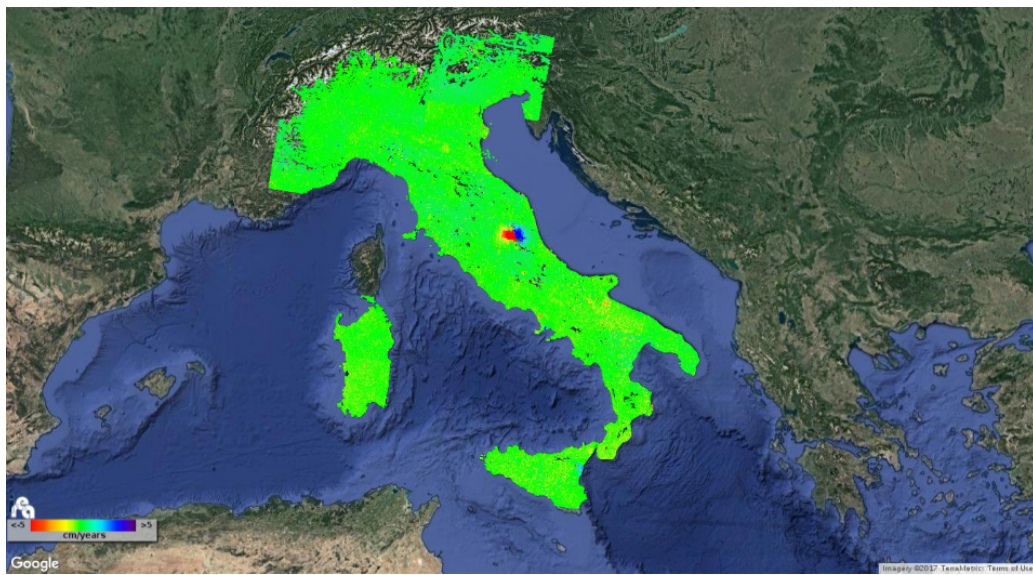
Figure 12. Sentinel-1 DInSAR mean deformation velocity map of whole Italian territory uploaded to the extended GeoNode platform.